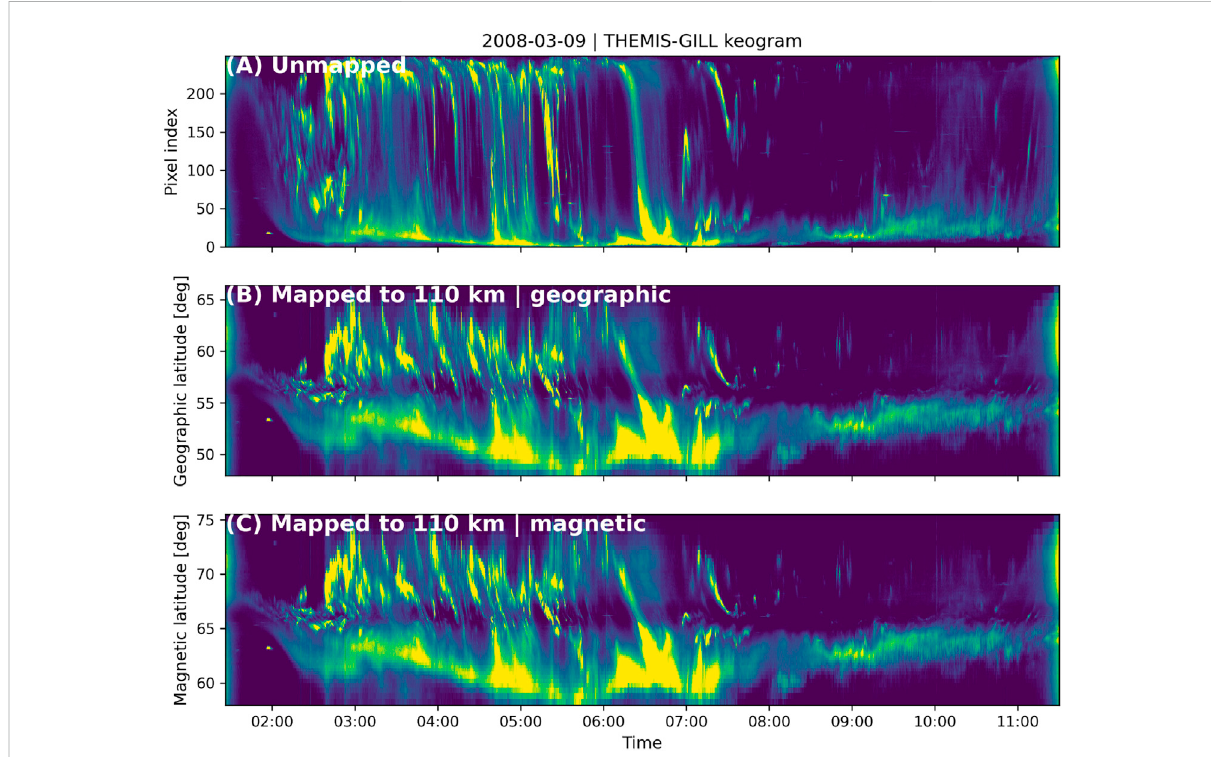
FIGURE 3 A full-night keogram showing the dynamic aurora observed at Gillam, Canada on 9 March 2008. Panel (A) shows the unmapped keogram with the pixel index vertical axis, panel (B) shows the geographic latitude of the pixels mapped to 110 km altitude. Lastly, panel (C) shows the corresponding magnetic